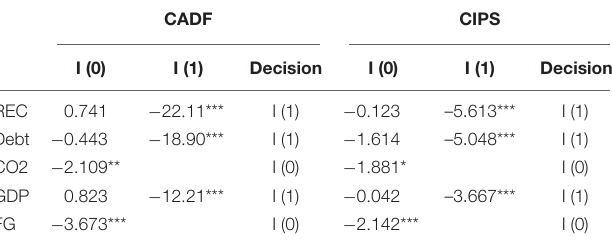
TABLE 3 | Panel unit root